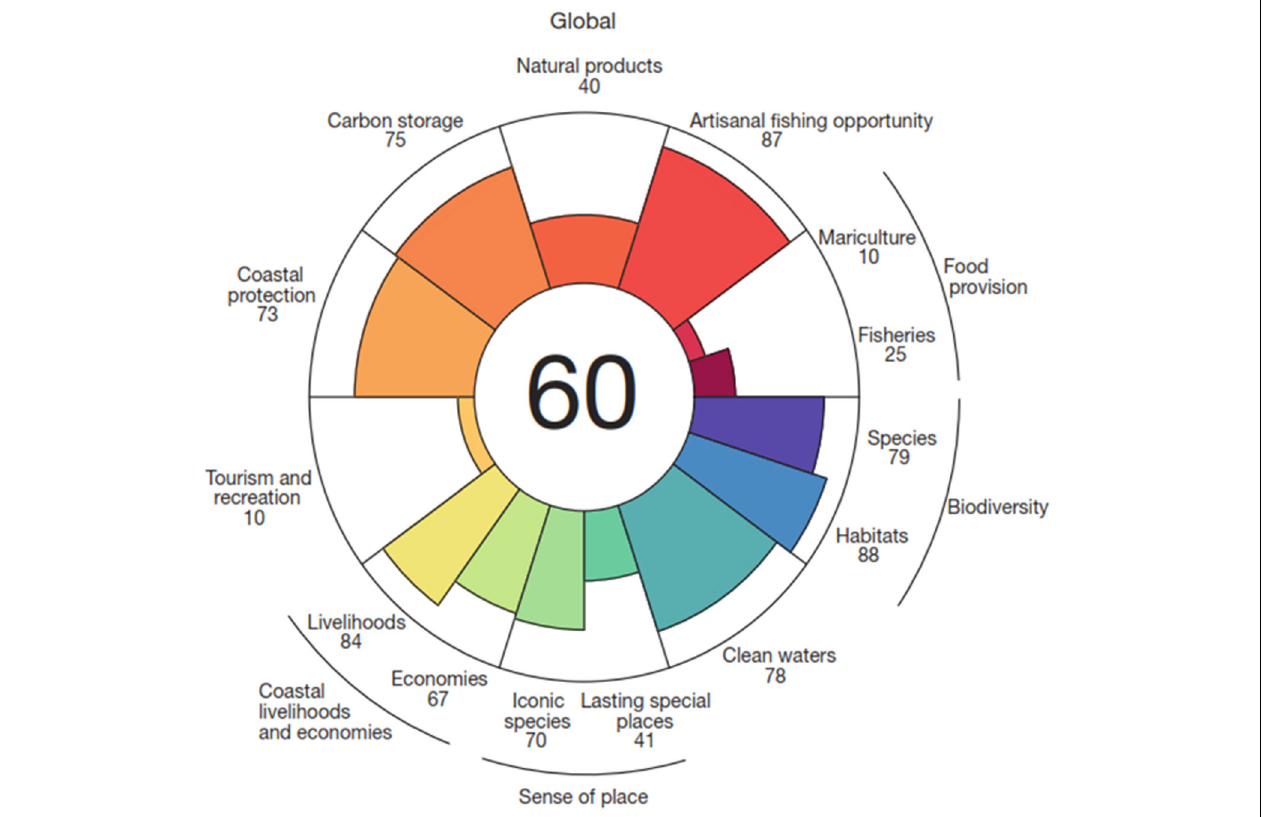
FIGURE 3 | Ocean Health Index scores (inside circle) and individual goal scores (colored petals) for global area-weighted average of all studied countries (modified from Halpern et al., 2012).